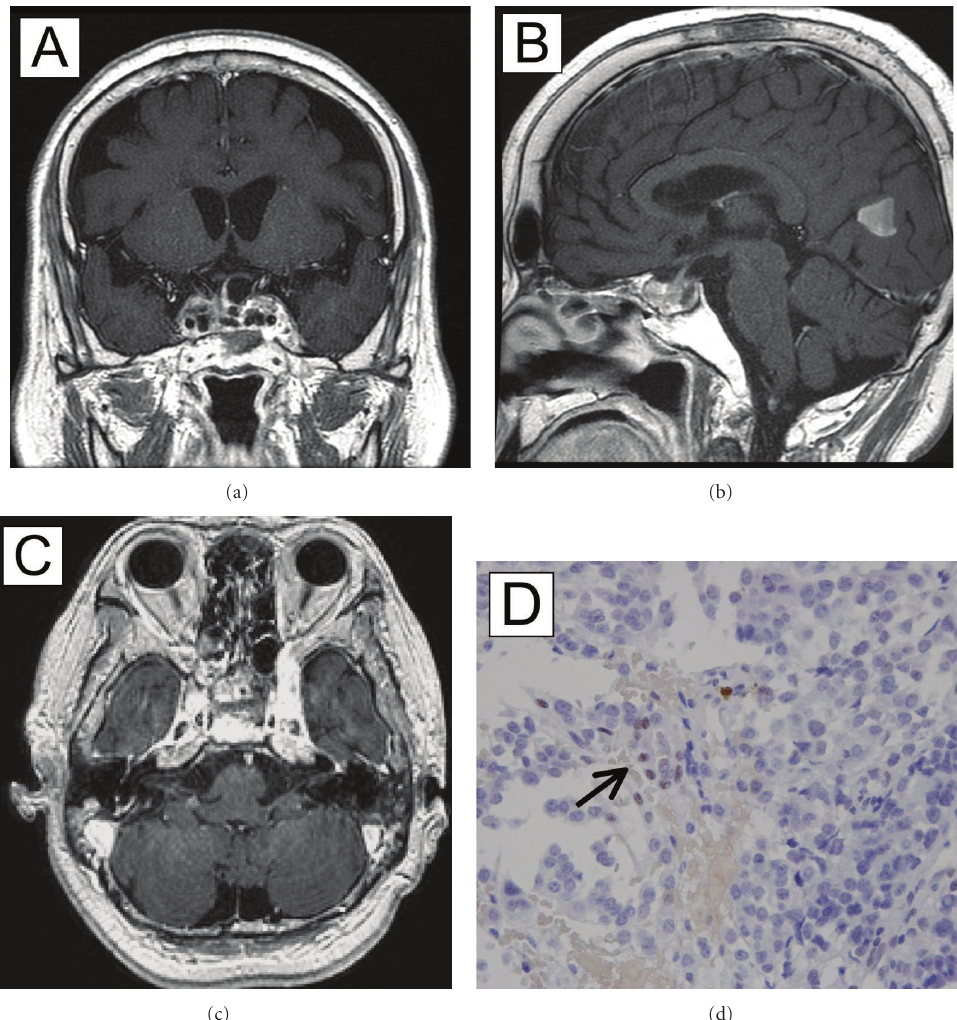
Figure 2: The pituitary carcinoma after 12 cycles of treatment. The pituitary tumor is decreased and limited mostly within the sella (contrast- enhanced MRI). The left temporal lobe is not invaded by the tumor (a). The metastatic brain tumor in the occipital lobe grew smaller, without ringlike enhancement (b). The stalk was then identifiable (a and b). The meningeal dissemination regressed markedly (c). MGMT expression was negative in the pituitary tumor cells. MGMT was positive in the endothelial cells (arrow) and served as the internal positive control. MGMT staining was performed as described in